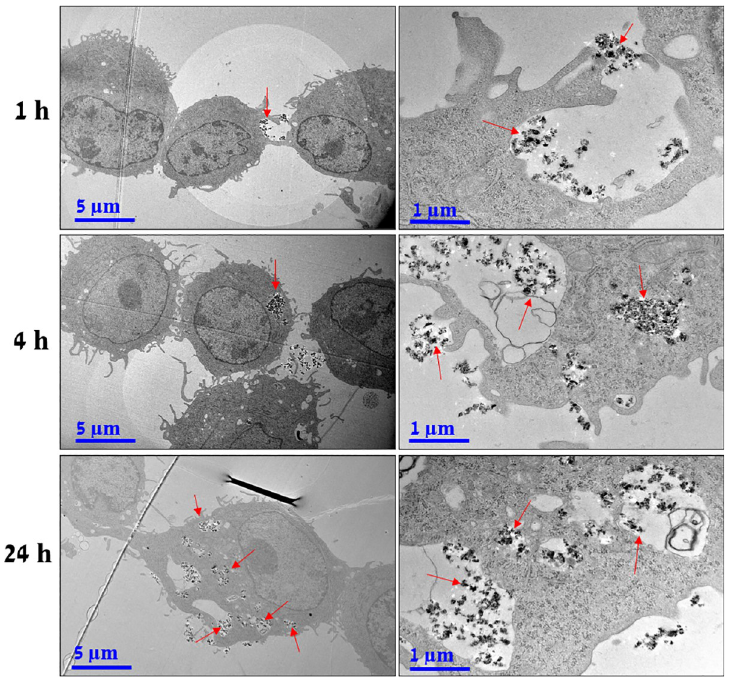
Fig 4. TEM images showing uptake of NP (indicated by red arrows) in mouse RAW 264.7 macrophages after 1 h (upper row), 4h (middle row), and 24 h (bottom row). https://doi.org/10.1371/journal.pntd.0009533.g004 the IC values with BPQ+NP was lower than pure BPQ indicating that the BPQ+NP was more 50 active than the pure BPQ to kill the amastigotes. The IC values of pure BPQ were larger than 50 with BPQ+NP by 3, 5, 5, and 4-fold against AG83, (AG83-R, SSG), (AG83-R, PMM), and GE1 strain, respectively. The efficacy to selectively kill the L . donovani amastigotes were assessed by